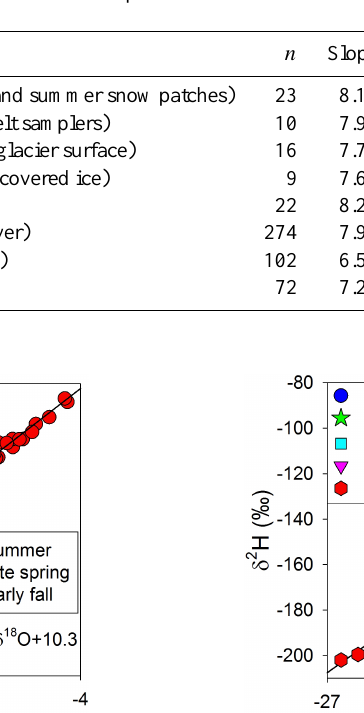
Table 4. Parameters of the linear relationship between δ 18 O and δ 2 H for snowmelt, ice melt and snowpack samples presented in Fig. 4, and for all stream water (Saldur and tributaries) and groundwater samples.